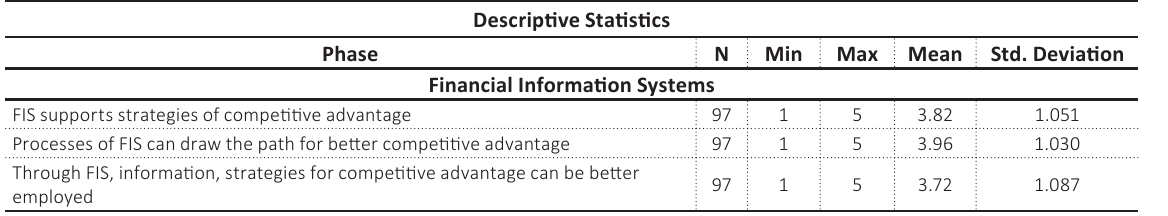
Table 2. Questionnaire descriptive statistics